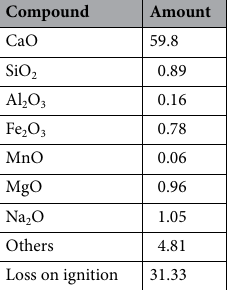
Table 2. Chemical composition of particulate snail shell employed in the present